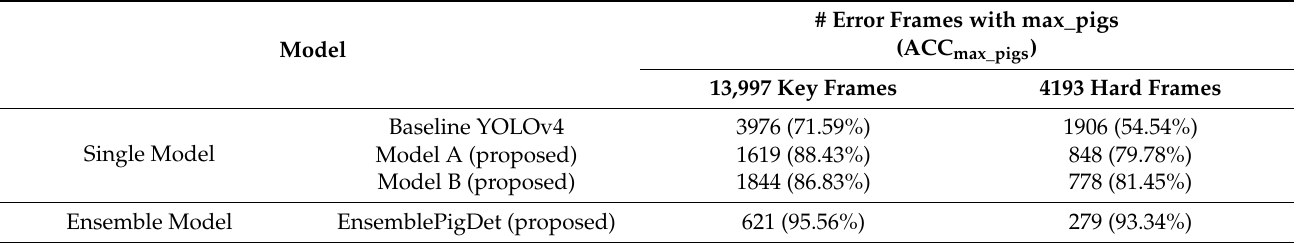
Table 4. Comparison of accuracy ACC max_pigs for 13,997 key frames and 4193 hard frames with overexposed regions (obtained during 8:30 a.m. to 10:30